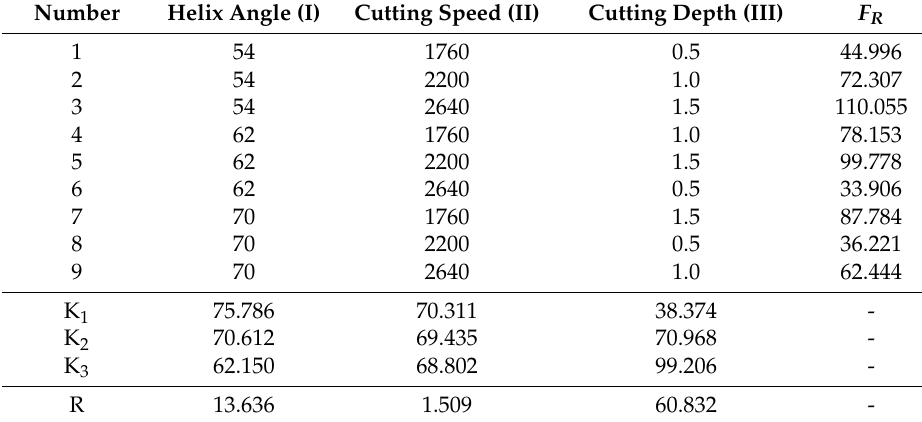
Table 4. Range analysis result of resultant force (N) under di ff erent helix angle ( ◦ ), cutting speed (m / min) and depth